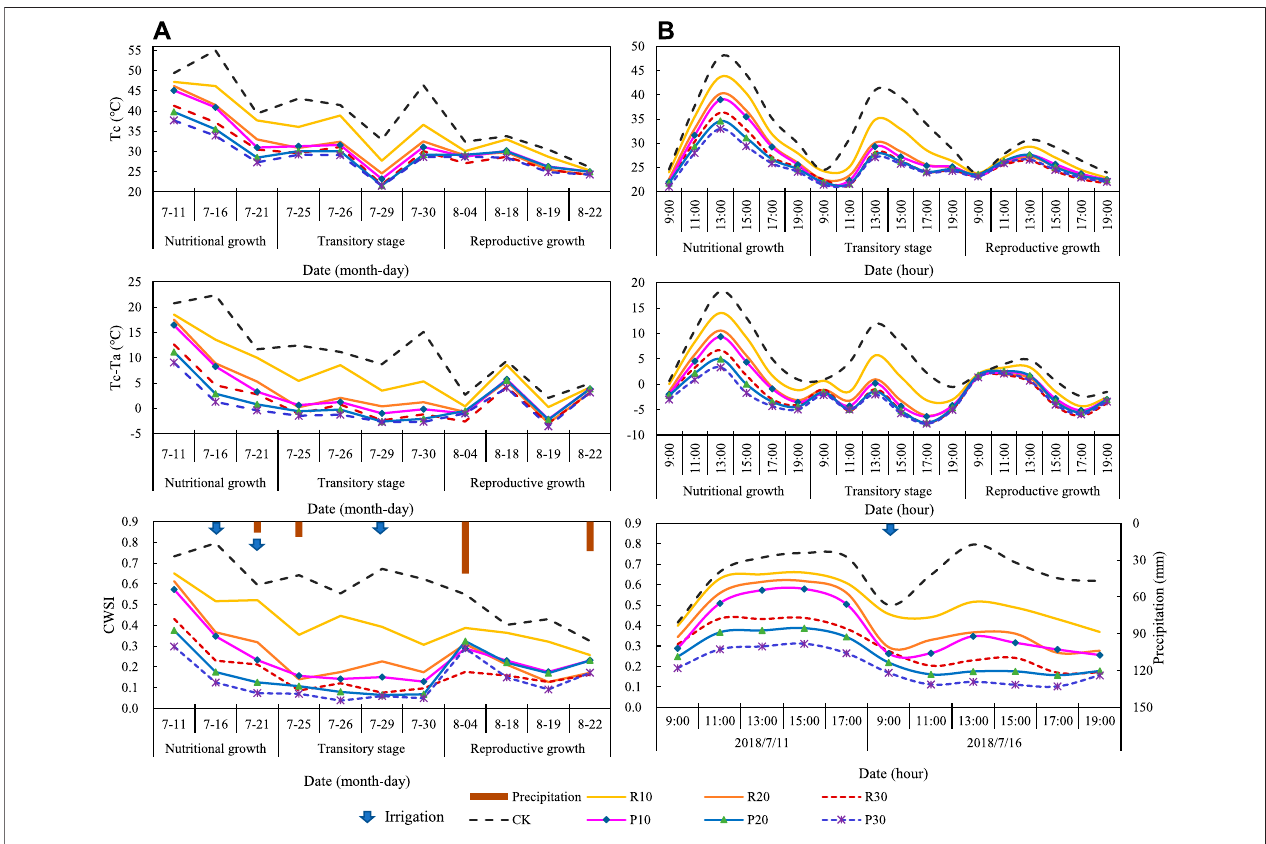
FIGURE4| The (A) dailyvariationsand (B) diurnalvariationsin(1)thecanopytemperature,(2)thedifferencebetweencanopytemperatureandairtemperature,and (3)thecropwaterstressindexofalfalfaunderdifferentirrigationmethodsbasedonUAVmonitoring. Thedailyvariationsre fl ectthemeanvaluesoftheentireplotforeach treatment, and the readings taken at 13:00. Precipitation data were for the fi rst 2 days of the observation period.